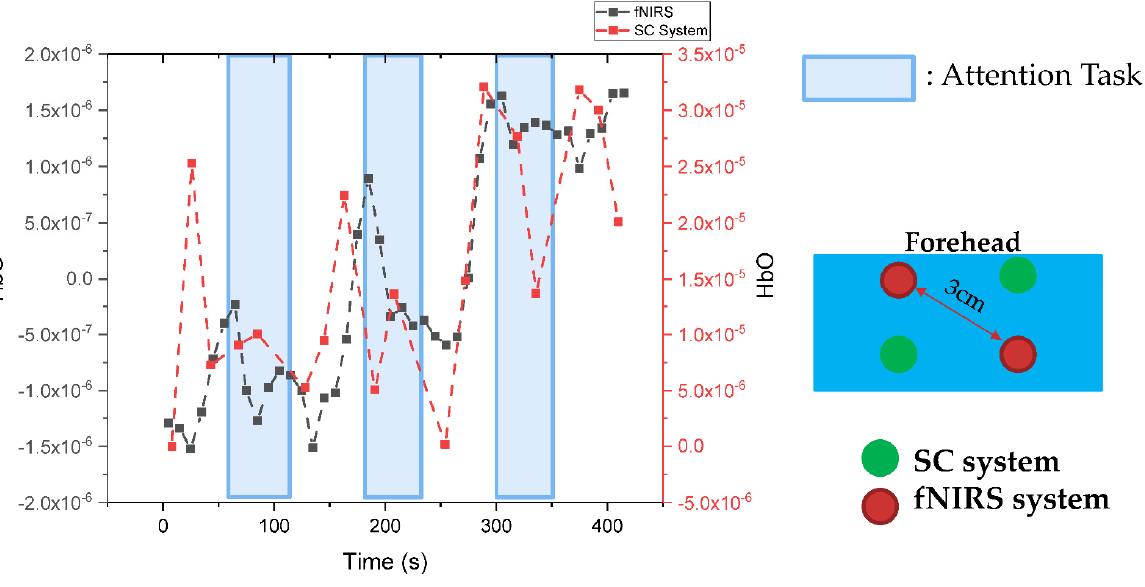
Figure 14. Using the probe of Figure 12 in the set-up of Figure 13, a comparison of the HbO measurements using fNIRS (black curve) and the SCISCCO system (red curve).